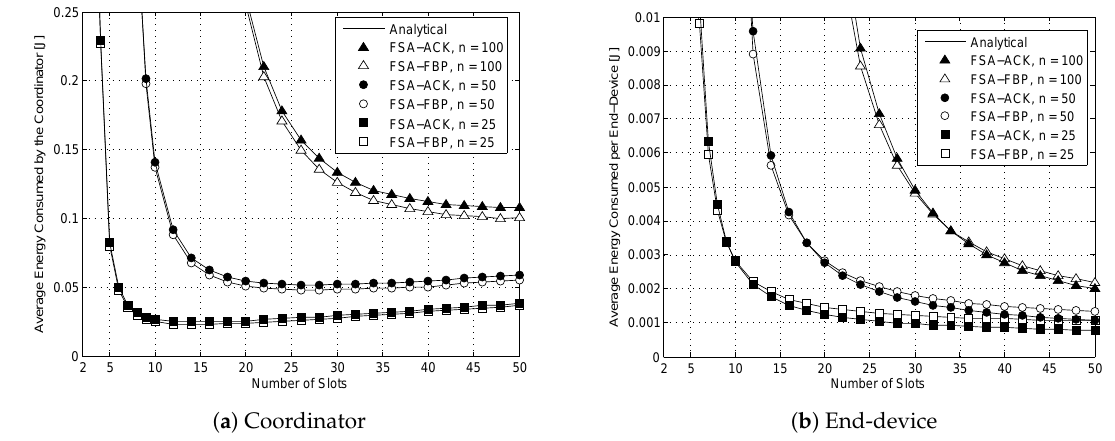
Figure 5. Coordinator and end-device average energy consumption using FSA-ACK and